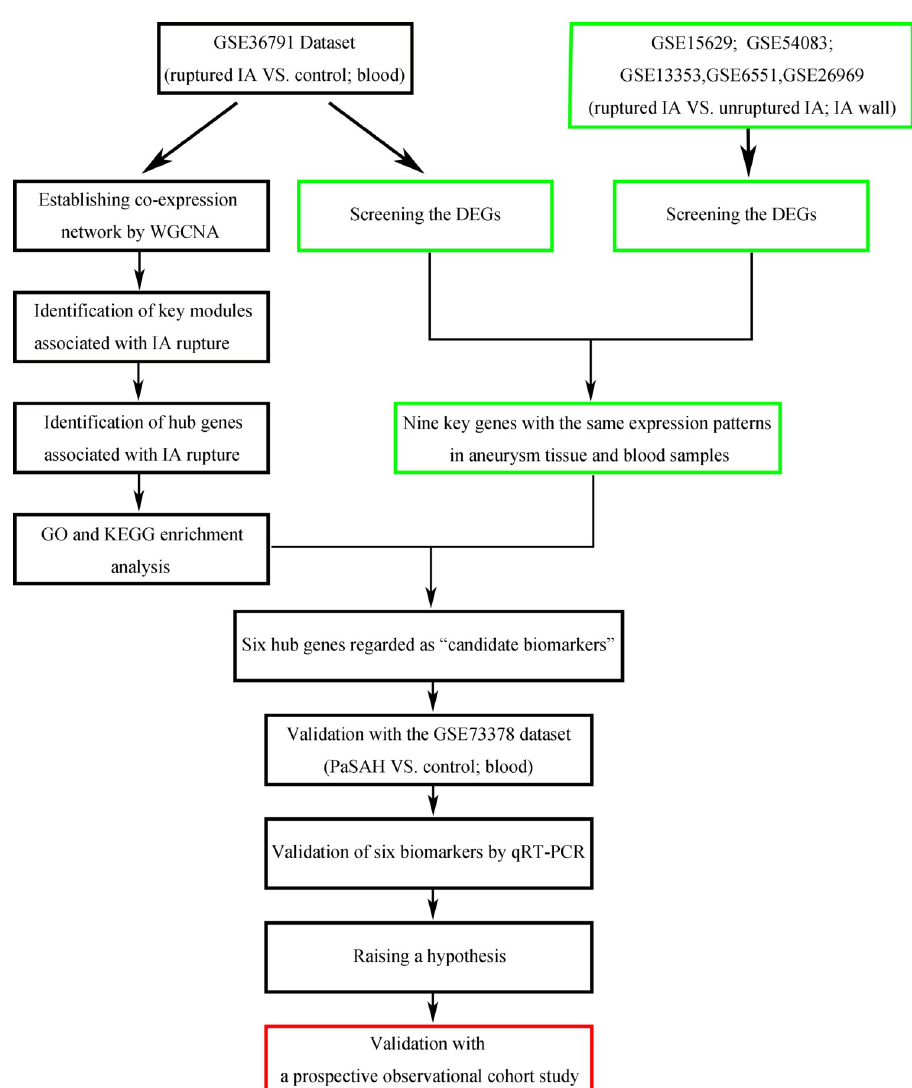
Fig 1. A flow chart illustrating the method used to identify six biomarkers associated with IA rupture. The entries shown in the green box were completed in our previous study, while the entries shown in the red box are those that we intend to focus on in future